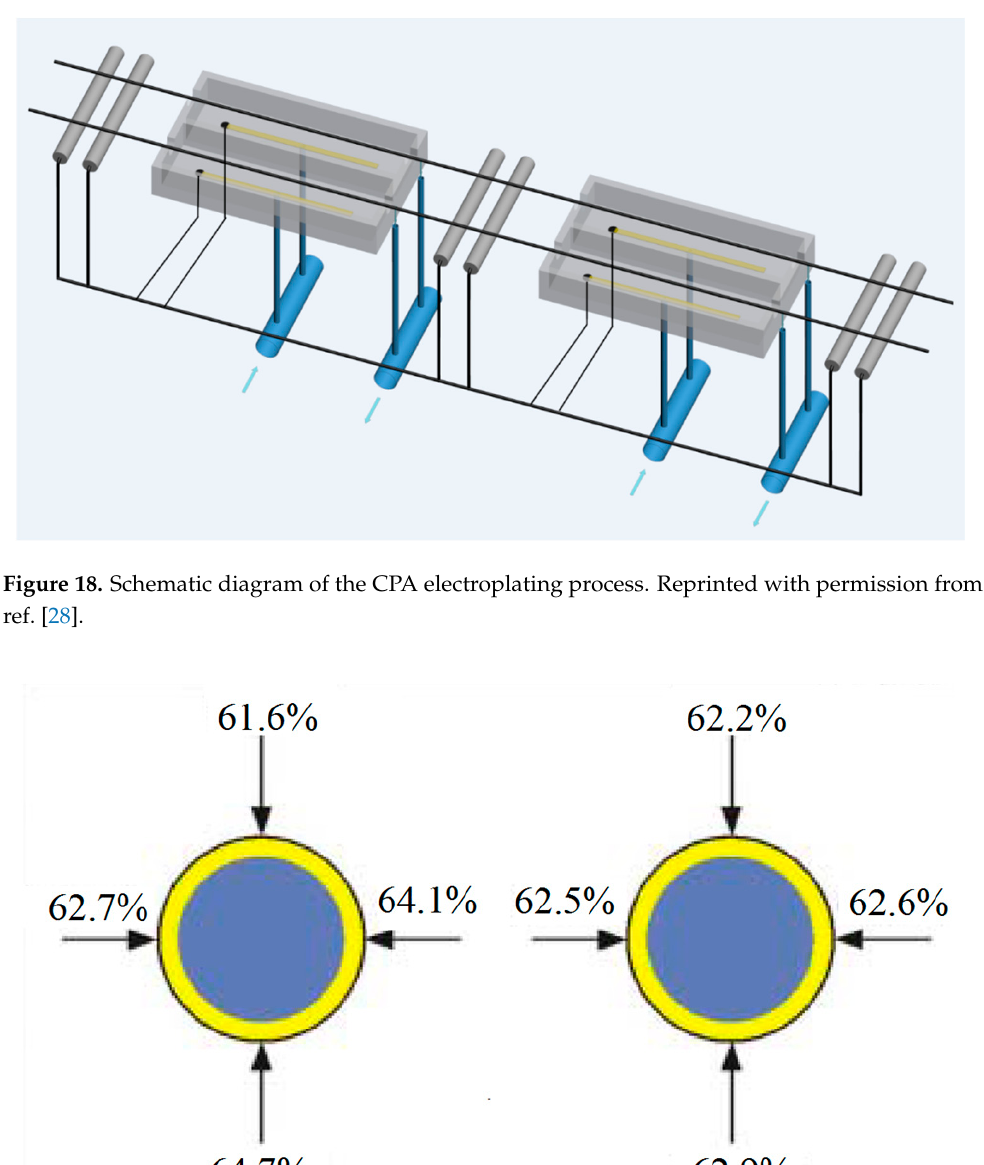
Figure 17. Diagram of deposition deviation in the case of horizontal positive plate. Reprinted with permission from ref. [28].